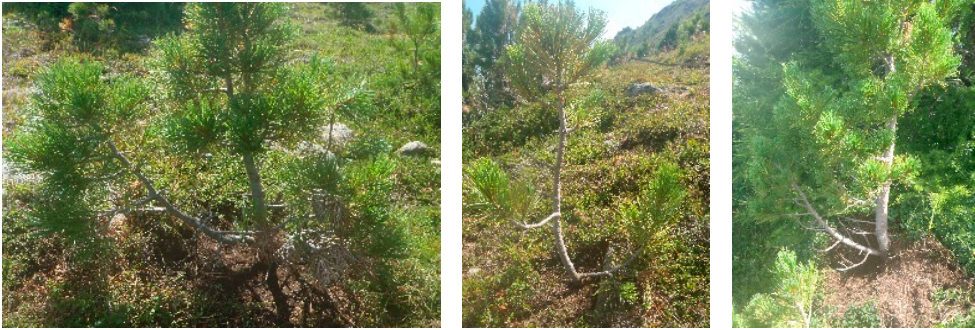
Figure 3. Examples of weak apical control of excavated basal branches of P. cembra saplings showing no damage to the leader shoot.